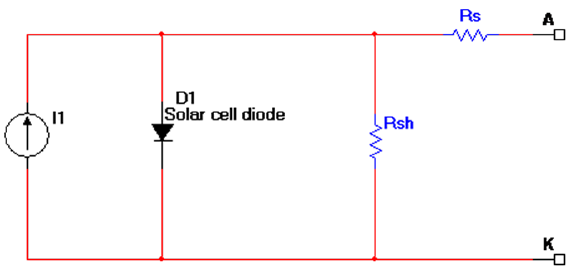
Figure 1. The DC equivalent electrical circuit of a solar cell.